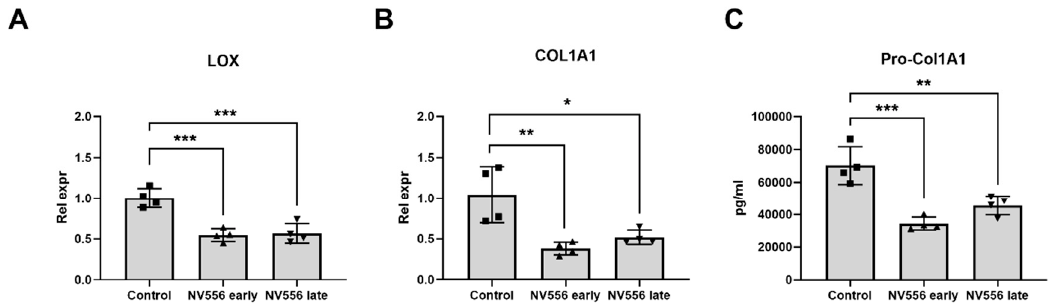
Figure 3. NV556 effect on gene expression ( A , B ) and procollagen secretion ( C ) in a 3D human liver model reseeded with LX2 cells. Data in A and B are represented as mean of relative expression over nontreated control cells ± SD, and data in A – C are statistically analyzed by one-way ANOVA, followed by Tukey’s multiple comparison test. * p < 0.05, ** p < 0.01 and *** p < 0.001, n = 4 scaffolds per condition investigated.